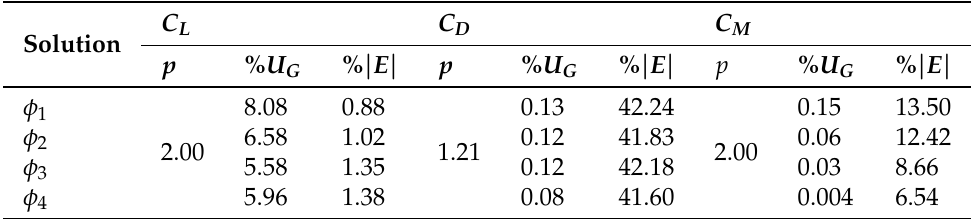
10 − 4 c ,4.46 10 − 4 c ,3.15 10 − 4 c × × ×